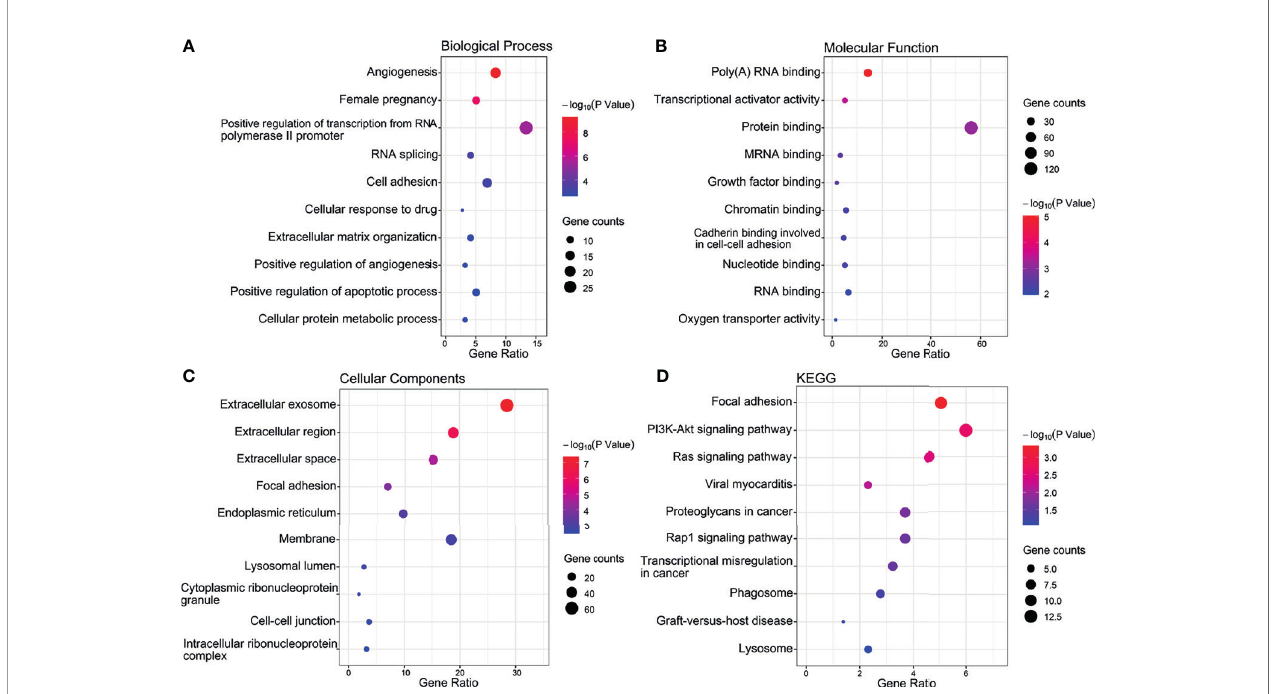
FIGURE 6 | Top 10 signi fi cant enrichment GO and KEGG terms of DEGs. (A) BP, biological process. (B) MF, molecular function. (C) CC, cellular component. (D) KEGG, Kyoto Encyclopedia of Genes and